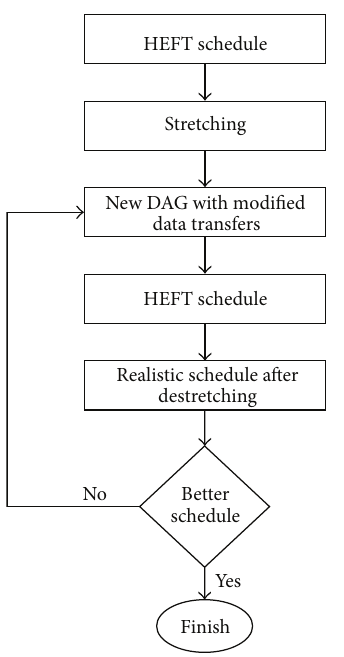
Figure 9: A flow chart of the network-aware HEFT methodology.